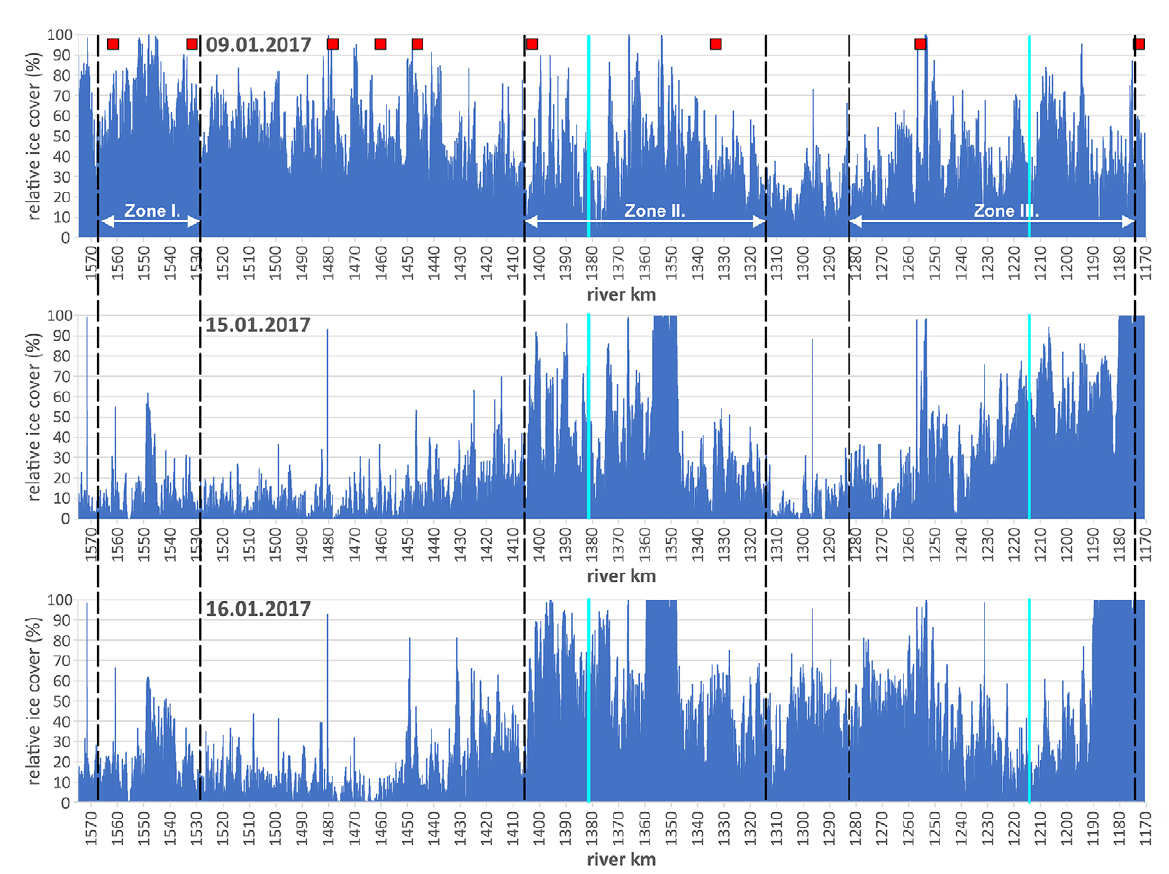
Figure 13. Changes in ice distribution on the study reach over three consecutive surveys. Red squares and cyan lines refer to the settlements and tributaries shown on Figure lower variation in width values, being in average 19.5